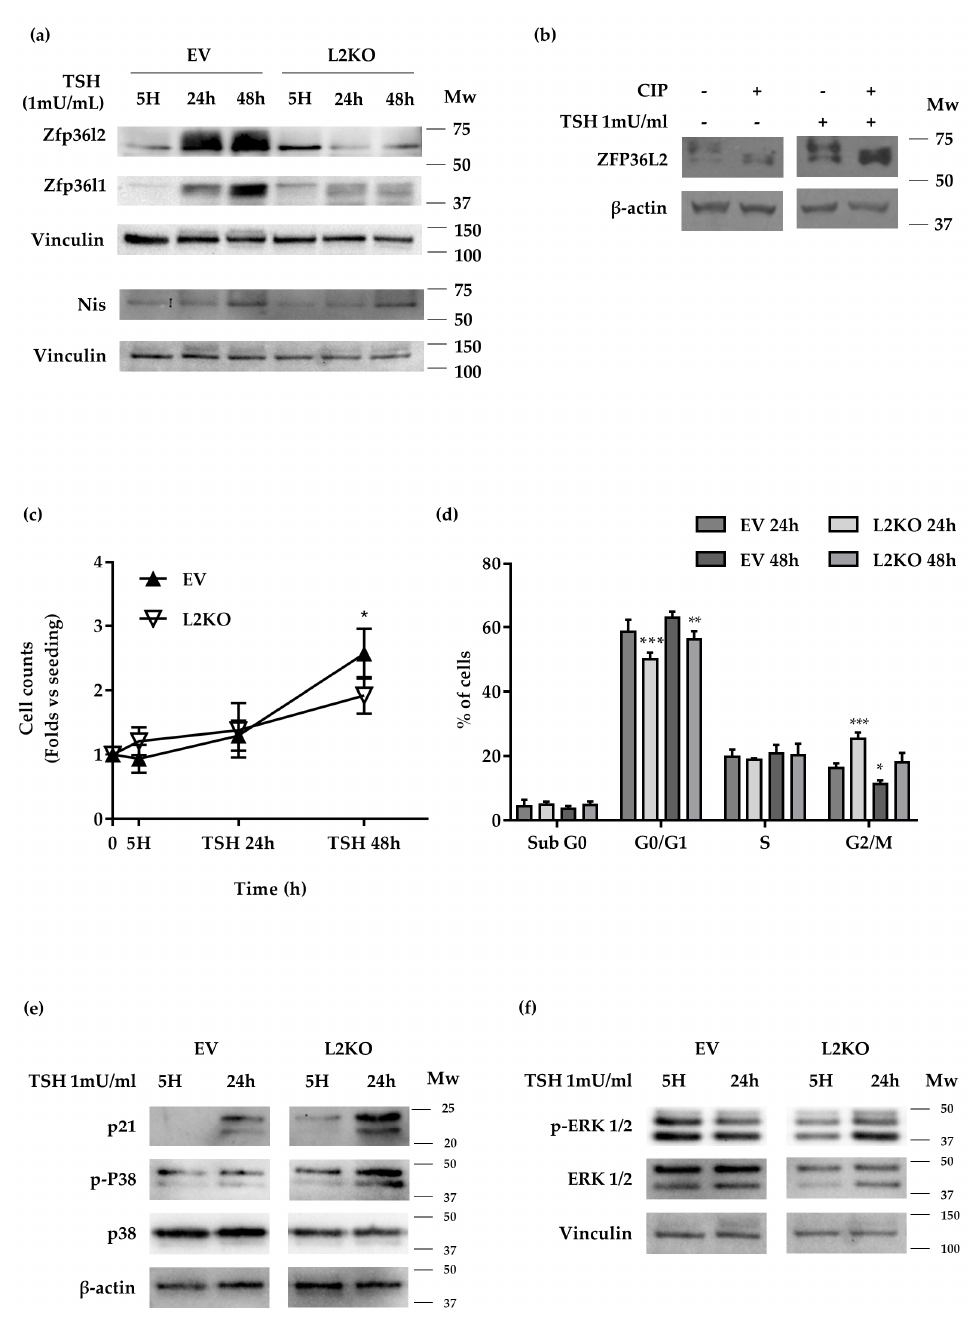
Figure 7. Characterization of the time-dependent response to TSH in L2KO and EV cells. Cells were TSH-starved and then stimulated for the reported time as detailed in M&M. ( a ) Western blotting analysis of ZFP36L2, ZFP36, L1, and NIS. ( b ) Analysis of the phosphorylation of ZFP36L2 after TSH induction and Calf Intestinal Phosphatase (CIP) treatment of the whole cell lysate. Absence of the ZFP36L2 signal after CIP treatment demonstrates that TSH induced protein phosphorylation. ( c ) Cell counting conducted on detached cells stained with trypan blue. The indicated time points on the - axis are, 0, number of cells at seeding time; 5H, number of cells after 3 days starvation; TSH 24h, number of cells after 24 h of stimulation with TSH 1mU/mL; TSH 48h, number of cells after 48 h of stimulation with TSH 1 mU/mL. ( d ) Analysis of the cell cycle was conducted by FACS analysis using Propidium Iodide staining on cells stimulated with TSH for 24 h or 48 h. ( e ) Western blot analysis of P21, P38-MAPK, and ( f ) ERK 1/2-MAPK. The activation status of the last two is reported (p-P38 and p-ERK). Trypan blue exclusion cell counts and FACS data reported as mean ± standard deviation of 3 independent experiments. * p < 0.05; ** p < 0.01; *** p < 0.001.